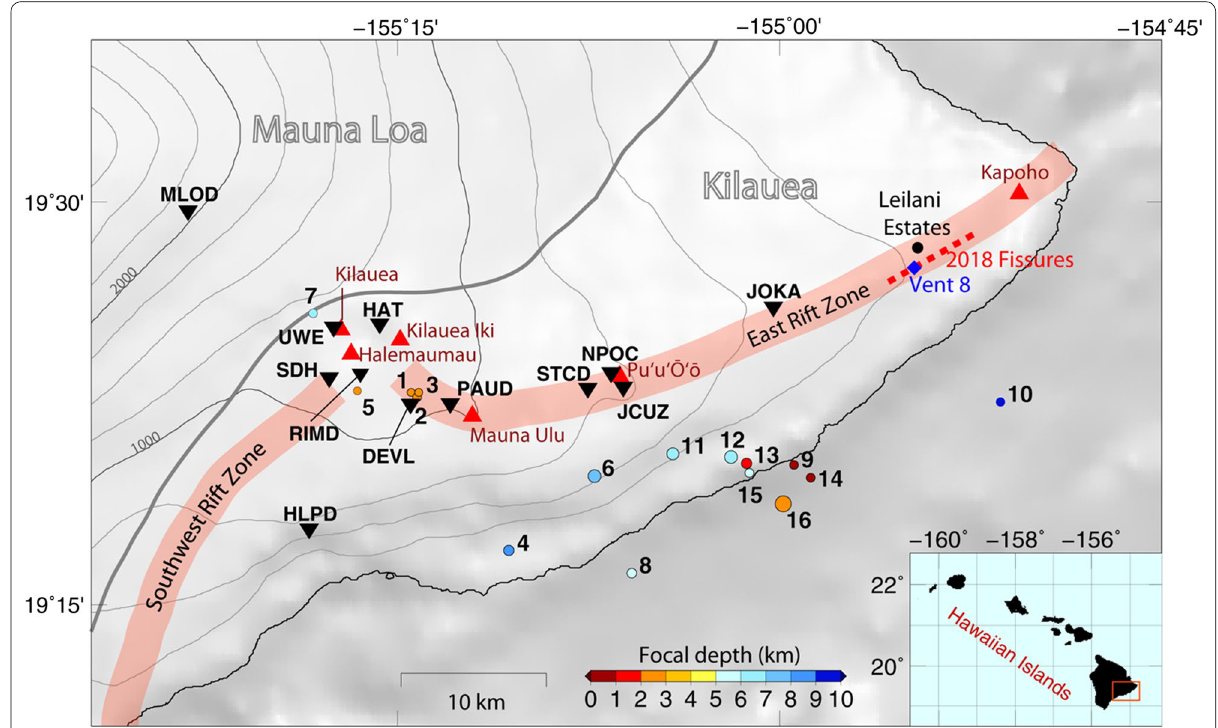
Fig. 1 Distribution of broadband stations used in the Kilauea area. The volcanoes, used seismic stations, and earthquakes with M ≥ 3.5 (from United States Geological Survey earthquake catalog) are shown by the red triangles, black inverted triangles, and circles color‑coded with focal depth. Red dash line marks the fissures opened during the 2018 eruption. The blue diamond marks the location of the most active fissure vent 8. Two shaded pink zones indicate the East and Southwest Rift zones (referred to Poland et al. 2014). The inset map shows Hawaiian Island chain and the location of our study area (red